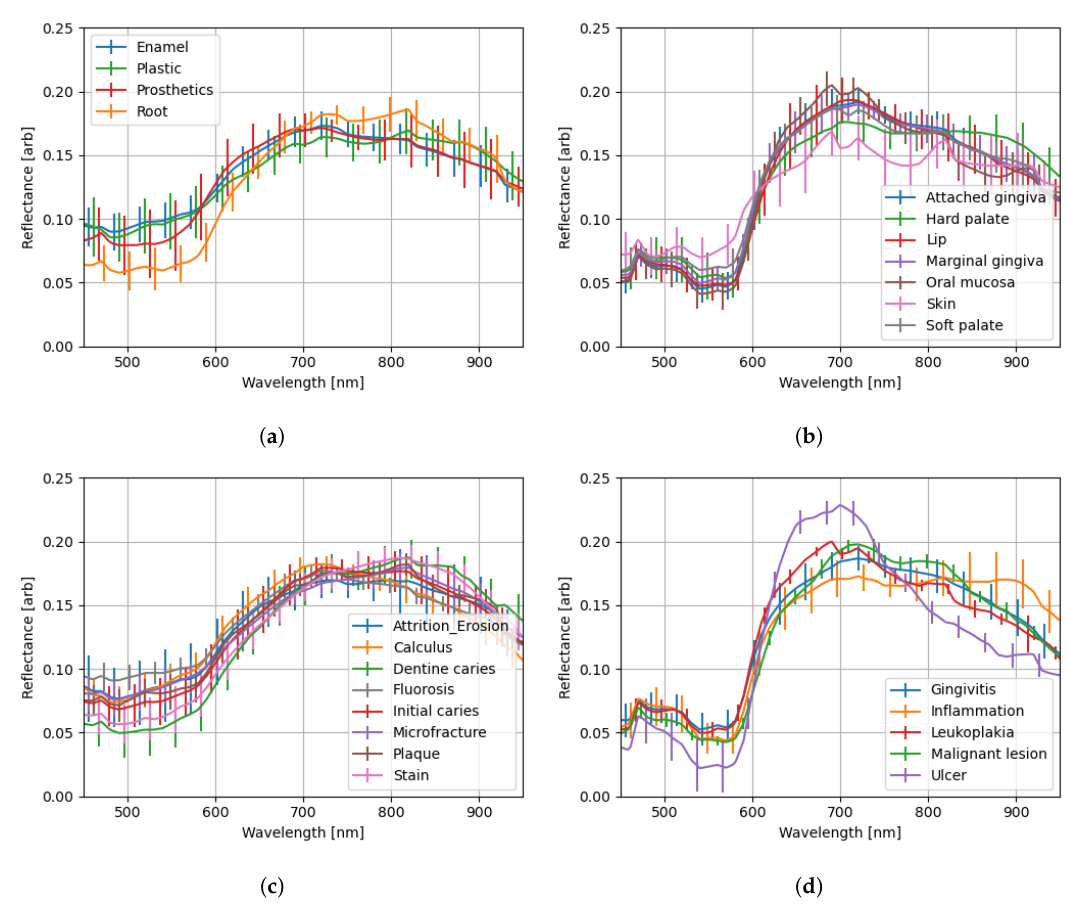
Figure 10. Means of L 2 -normalized spectra acquired with Nuance EX spectral camera, and their standard deviations for ( a ) hard tissue, ( b ) soft tissue, ( c ) hard tissue lesions, and ( d ) soft tissue